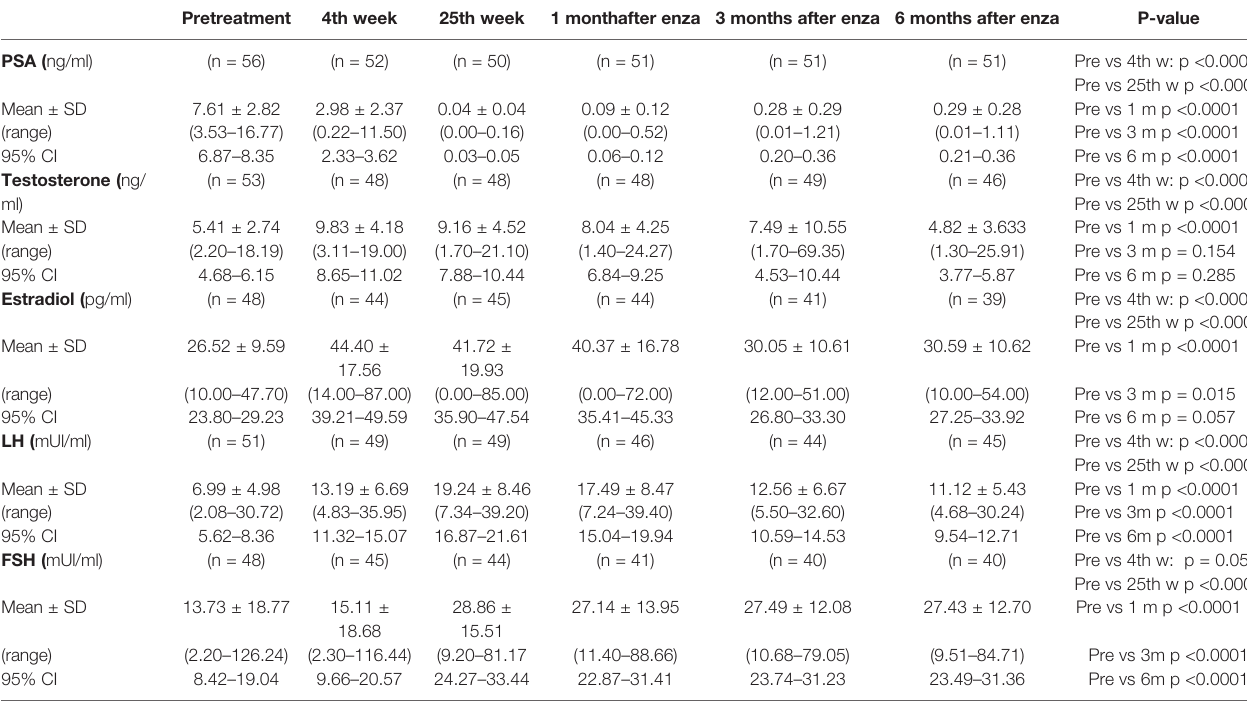
TABLE 4 | PSA and hormone pro fi le values at pre-speci fi ed time points. Pretreatment